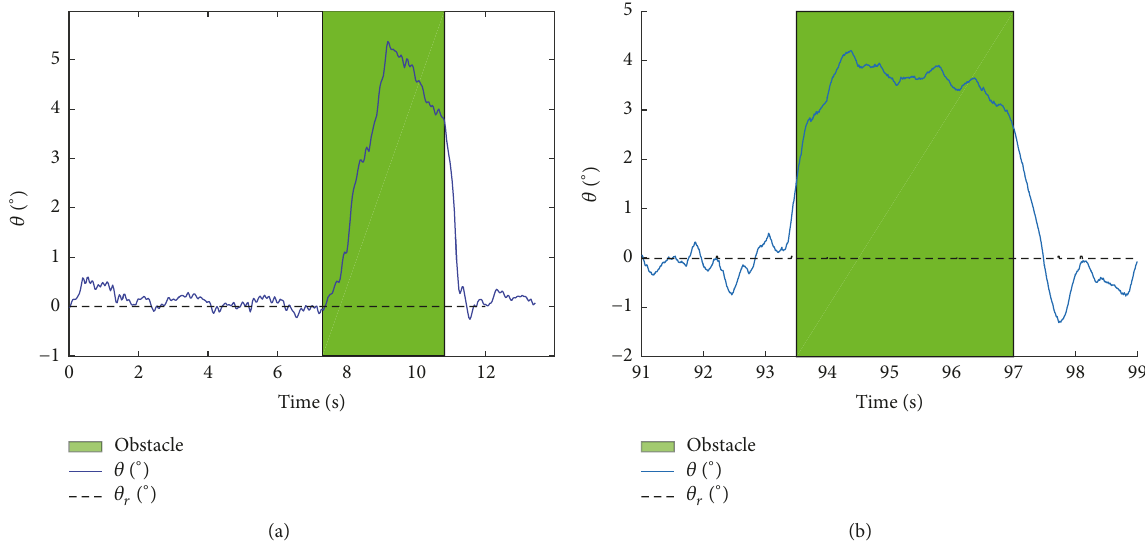
Figure 26: Experiments in the test bench: influence on the pitch angle of placing a ground plane under one of the rotors (green background). (a) Effect in the PQUAD multirotor. (b) Effect in the AMUSE multirotor.